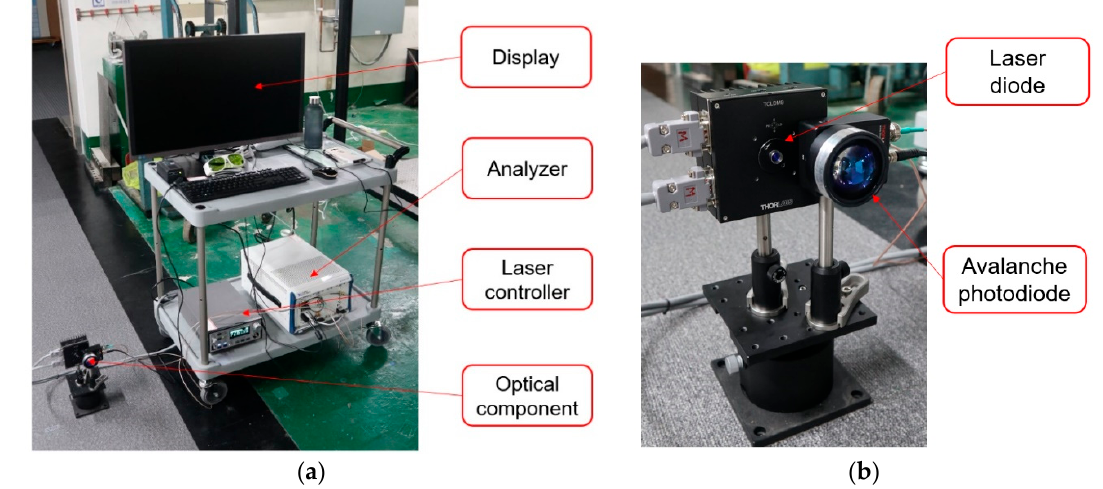
Figure 5. ( a ) The whole distance measurement system; ( b ) optical components of the